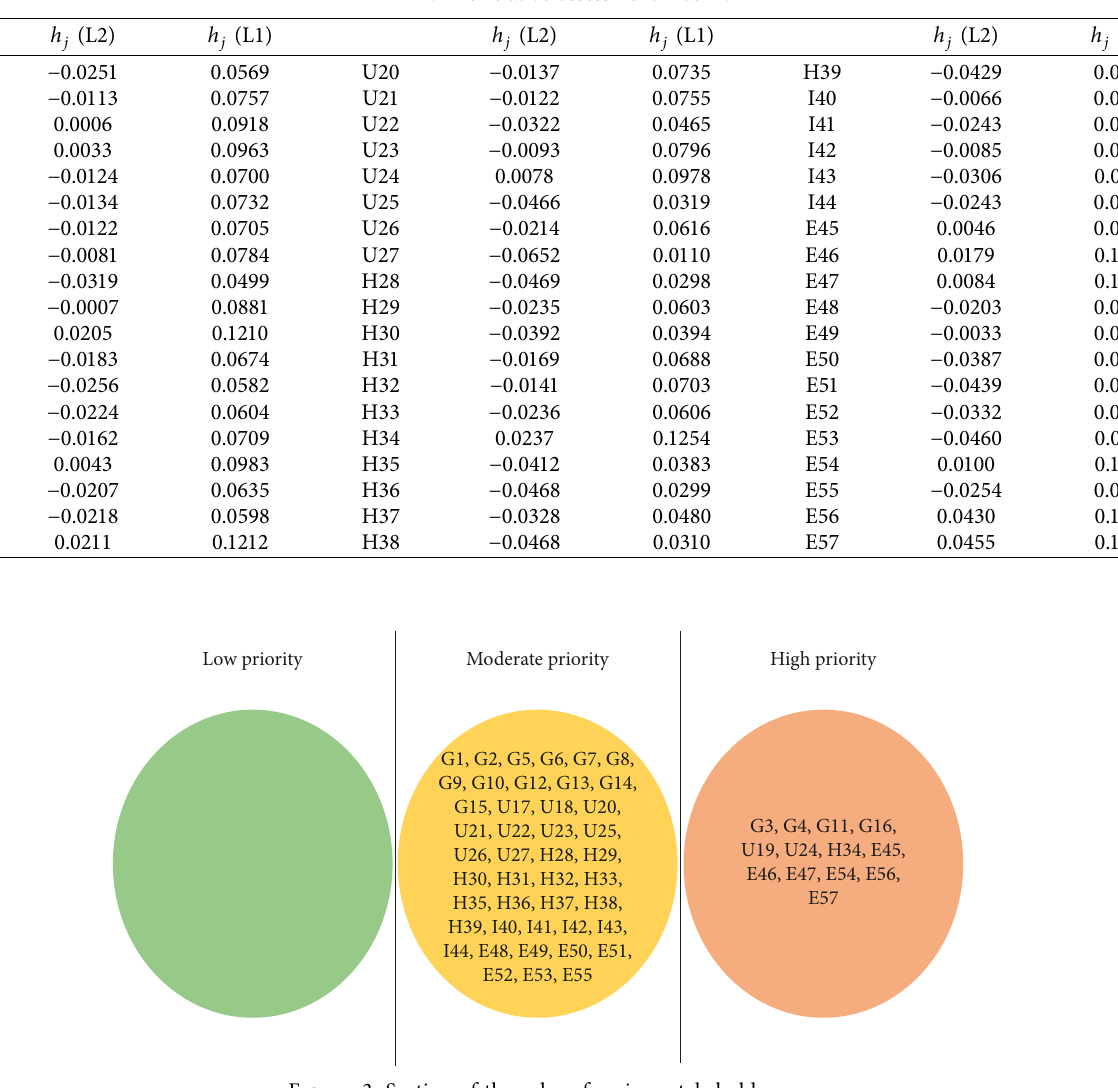
Table 12: The relative assessment matrix.